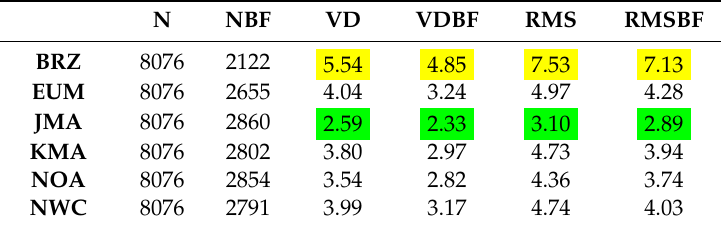
Table 6. Experiment 1: The same as Table 5, but with Common Quality Indicator >= 80%.